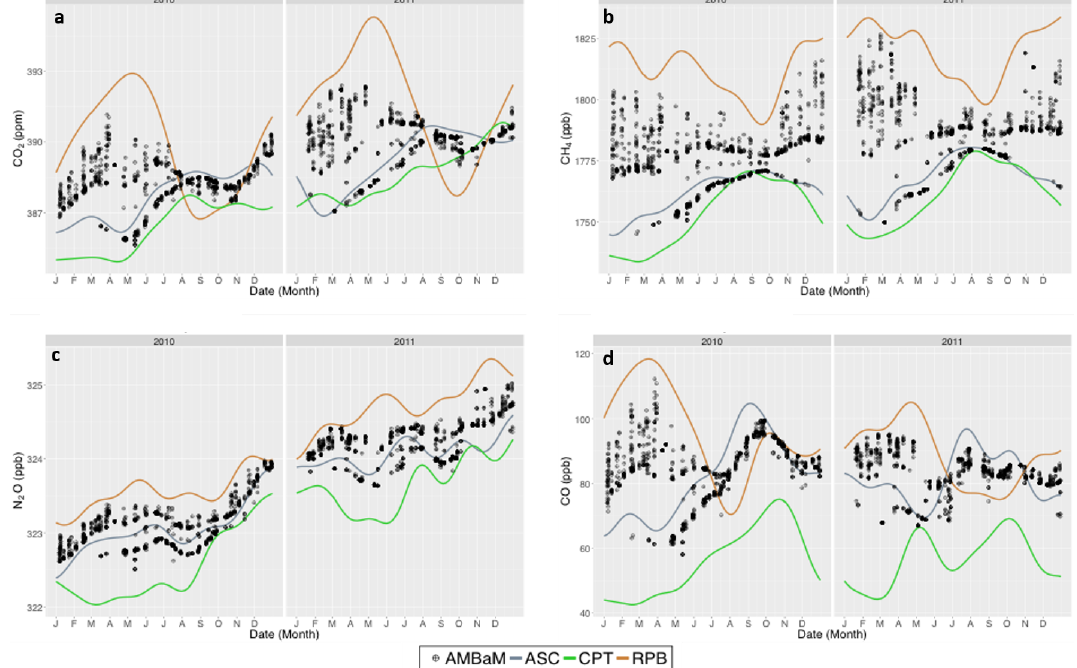
Figure 3. Barbados (RPB), Ascension Island (ASC) and Cape Point station (CPT) 2010 and 2011 time series with the AMBaM BKG results per profile for the studied gases. ( a ) CO 2 results. ( b ) CH 4 results. ( c ) N 2 O results. ( d ) CO